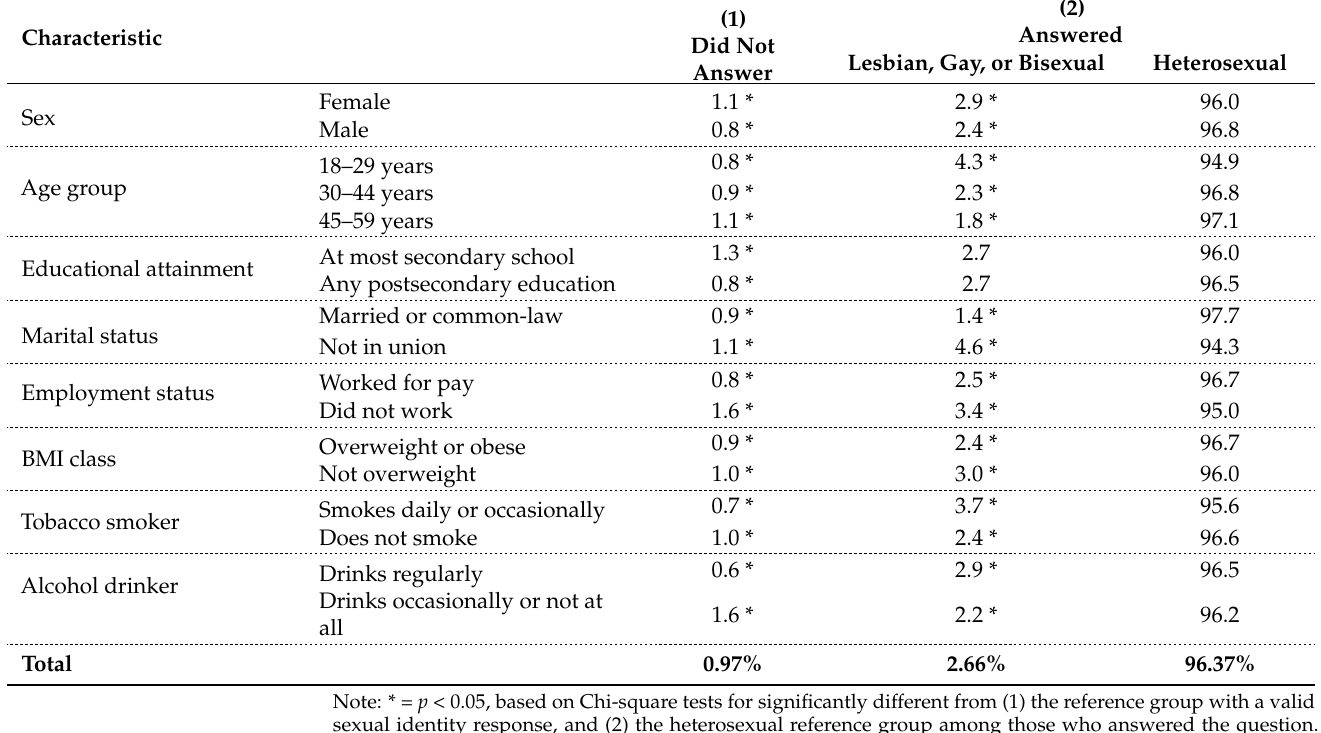
Table 1. Percentage distribution of survey respondents aged 18–59 by their response to the question on sexual identity, according to sociodemographic characteristics and cardiometabolic risk factors.